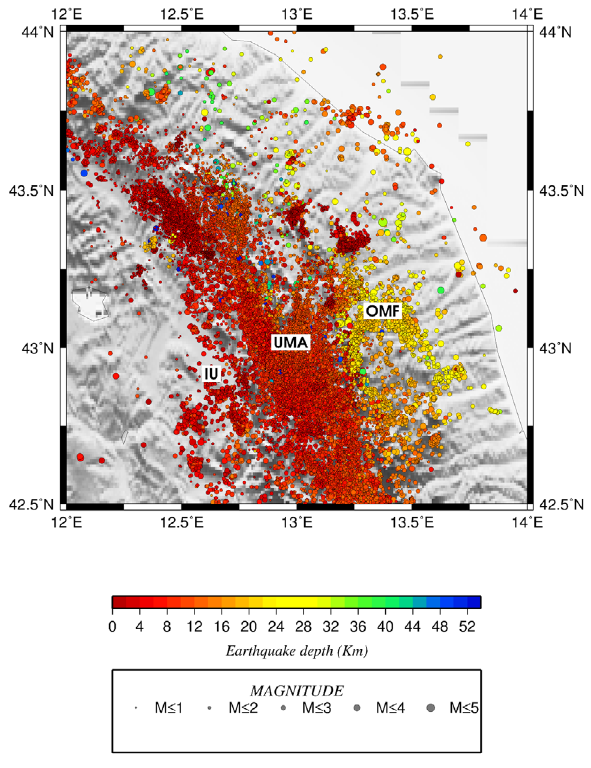
Figure 2. Seismicity recorded in the period 1996-2012. Size of the symbols is proportional to magnitude, color is a function of focal depth. IU = inner Umbria; UMA = Umbria–Marche Apennines; OMF = outer Marche